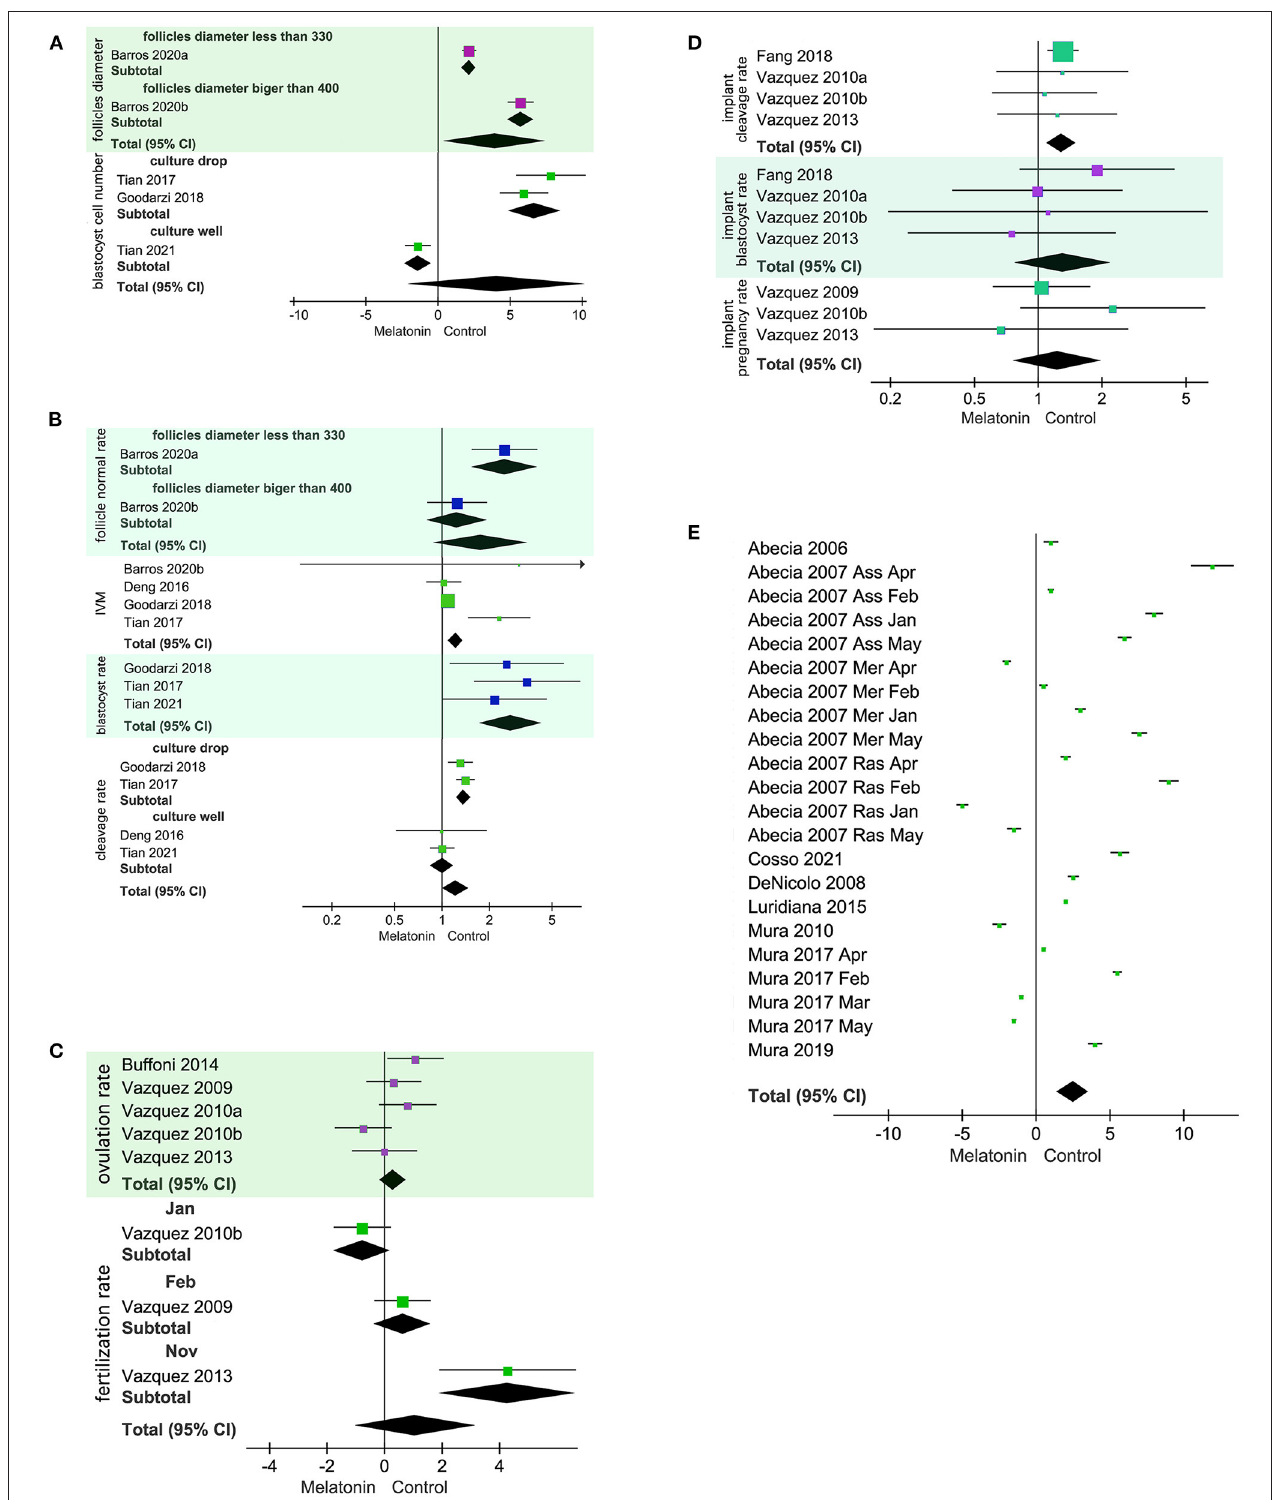
FIGURE 2 | Forest plot of melatonin (MT) treatment effects on sheep oocytes. The subgroup analysis was based on different follicle diameters, different culture treatments, and different months. (A) SMD for the effects of in vitro culture of exogenous MT on follicle diameter and blastocyst cell number. Blastocyst cell number analysis culture droplet subgroup I 2 = 36%. (B) RR for the effects of in vitro culture exogenous MT on follicle normal rate, IVM rate, cleavage rate, and blastocyst rate.